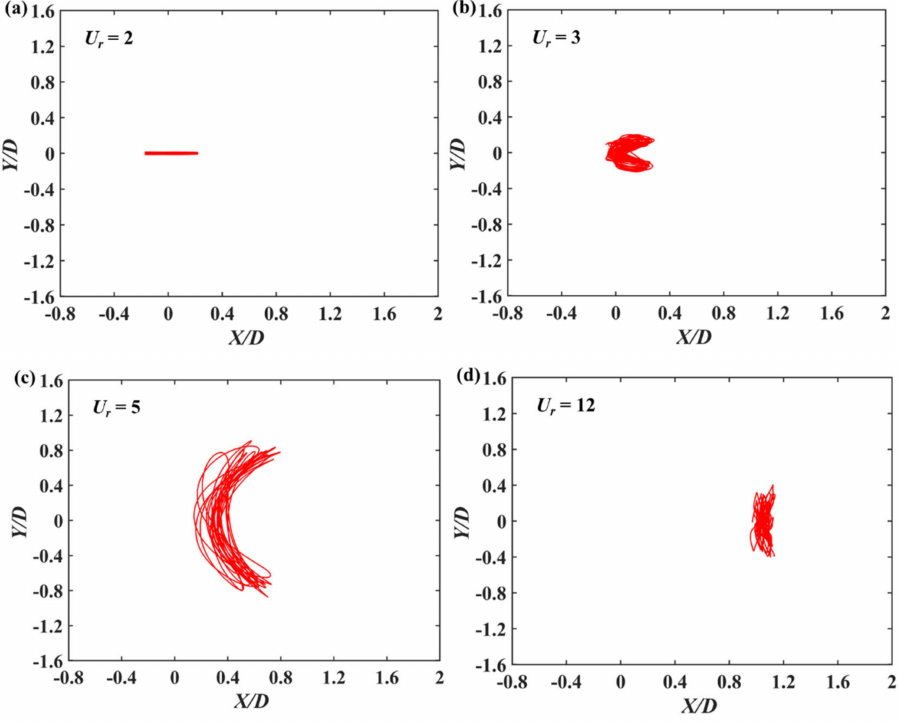
Figure 7. X-Y trajectory of two coupled cylinders at α = 0 ◦ and d/D = 0.3: ( a ) U r = 2; ( b ) U r = 3; ( c ) U r = 5; ( d ) U r = 12.